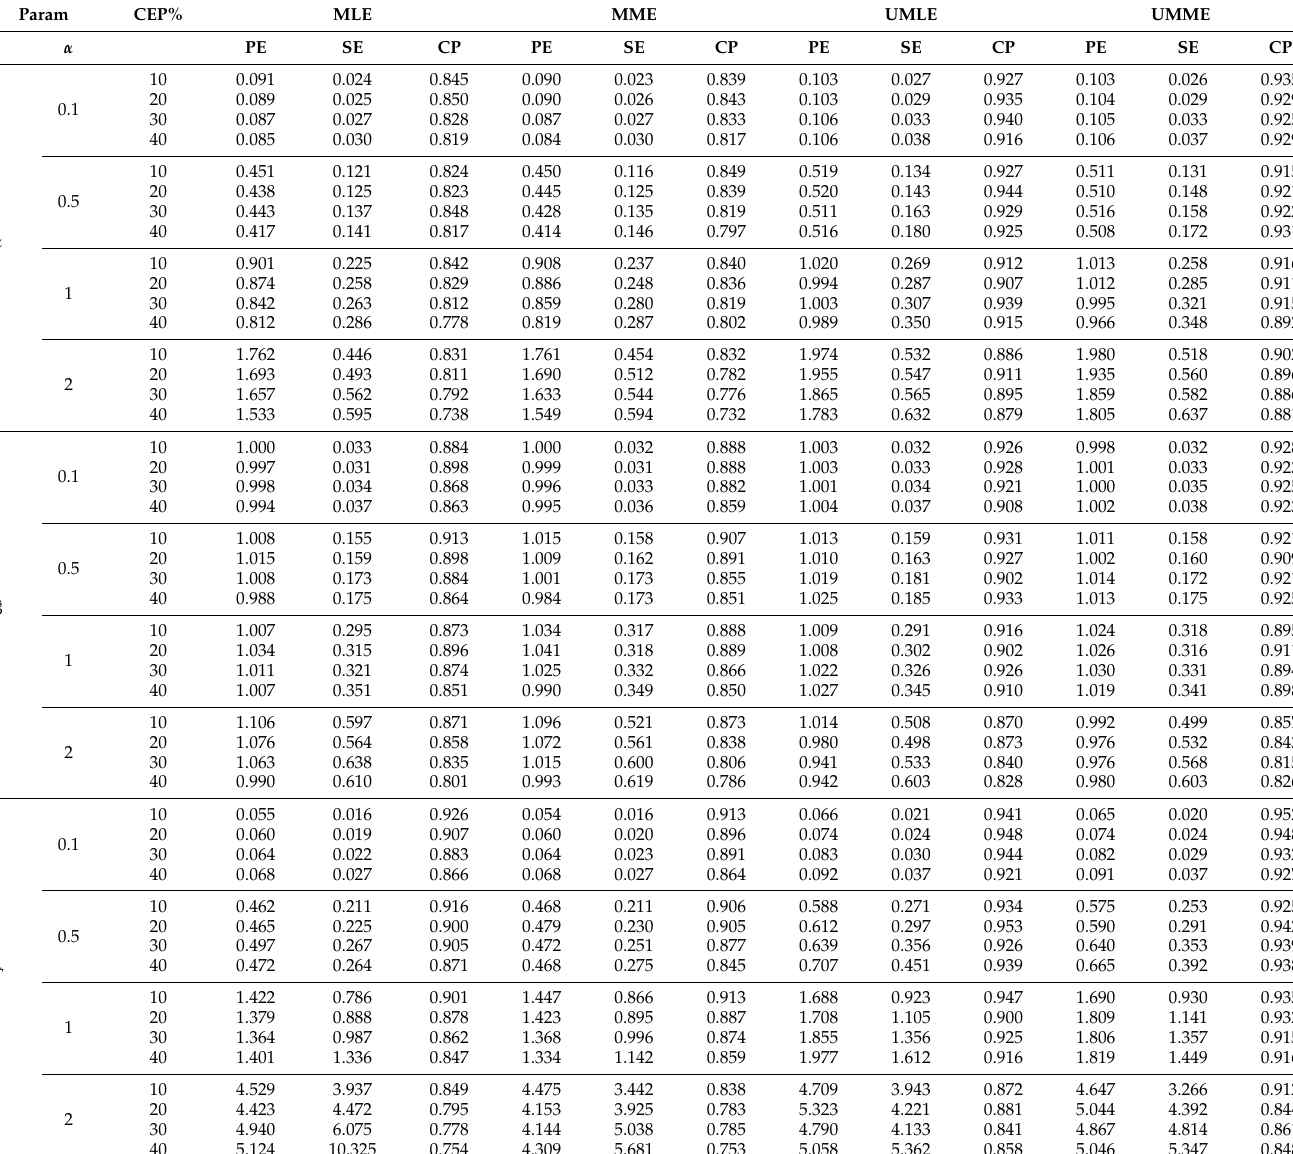
Table A1. Mean and standard error of the point estimates and probability coverages of 95% confidence intervals based on Monte-Carlo simulation ( n =